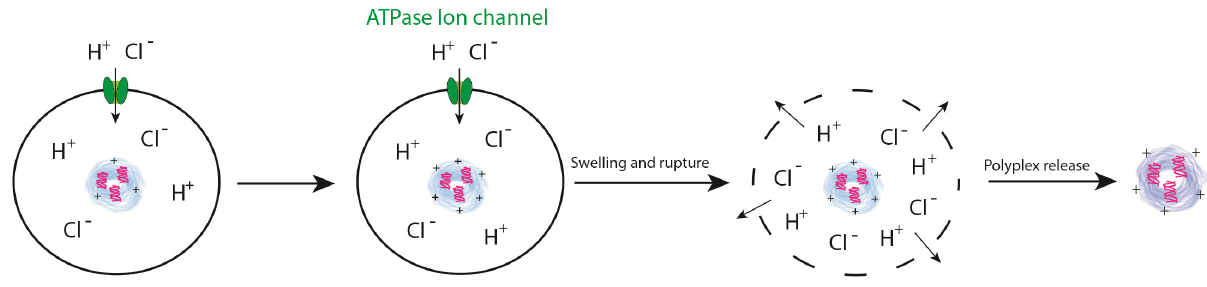
Figure 5. Schematic representation of the proton sponge effect that takes place after the cellular uptake of the polyplexex through an endosomal